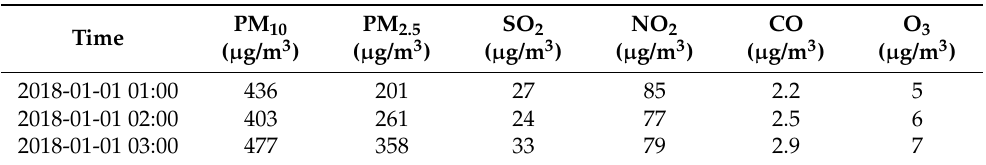
Table 1. Three-hour examples of air pollutant data from the Central Square Station of the Xi’an Xin Cheng district in Xi’an city from 2018 to 2020.